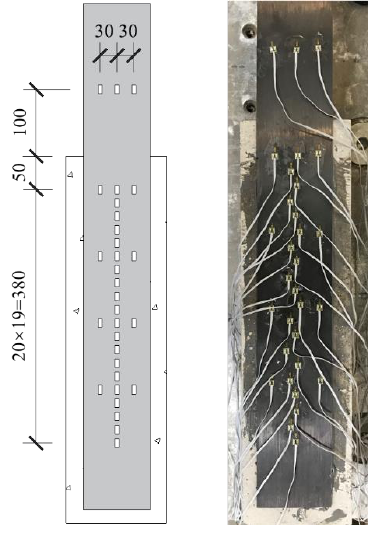
Figure 4. Detail of strain gauges arrangement.